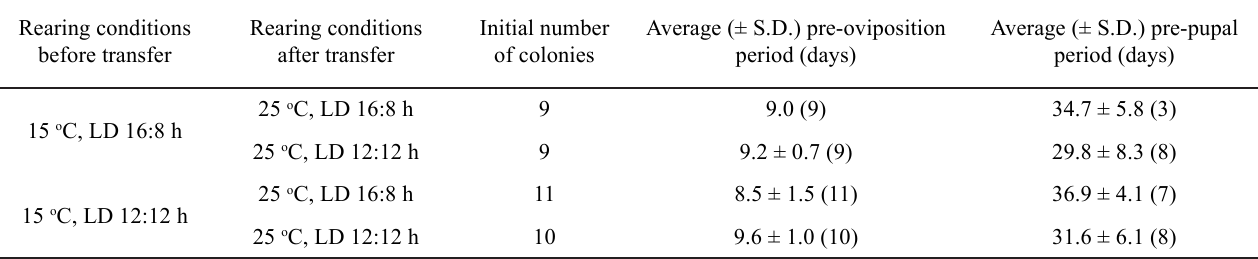
Table 2 . Effects of photoperiod on colony development after temperature rising in Lasius japonicus